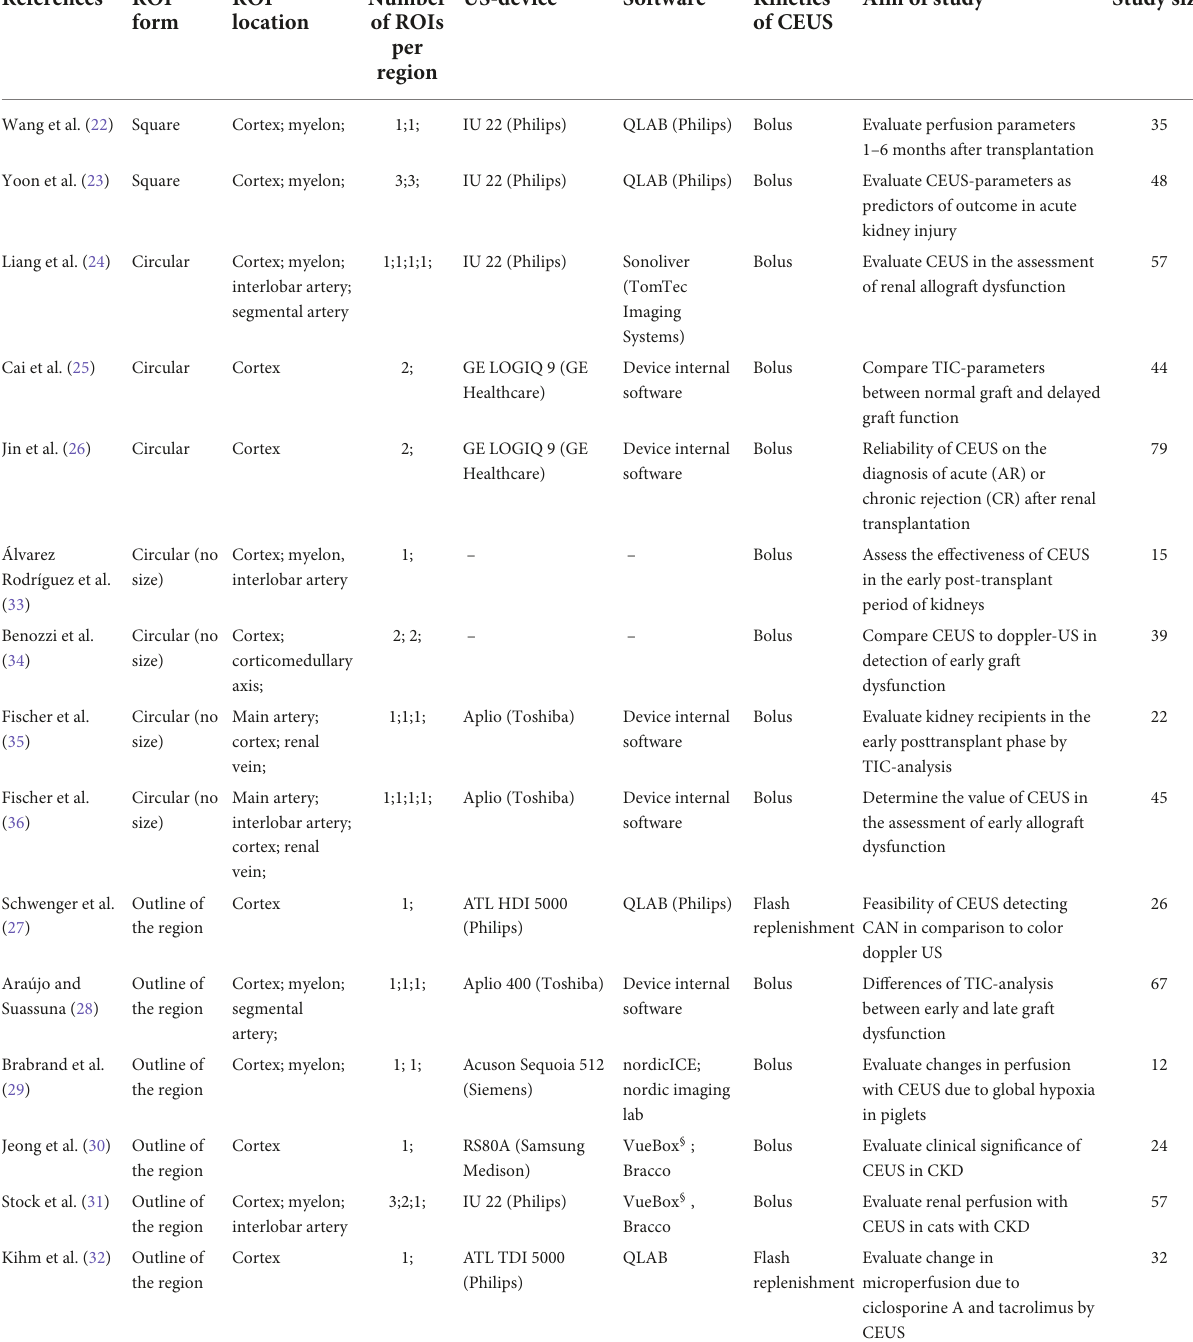
TABLE 11 Comparison of different ROI-sizes and -forms used for the TIC-analysis in kidney transplants in different